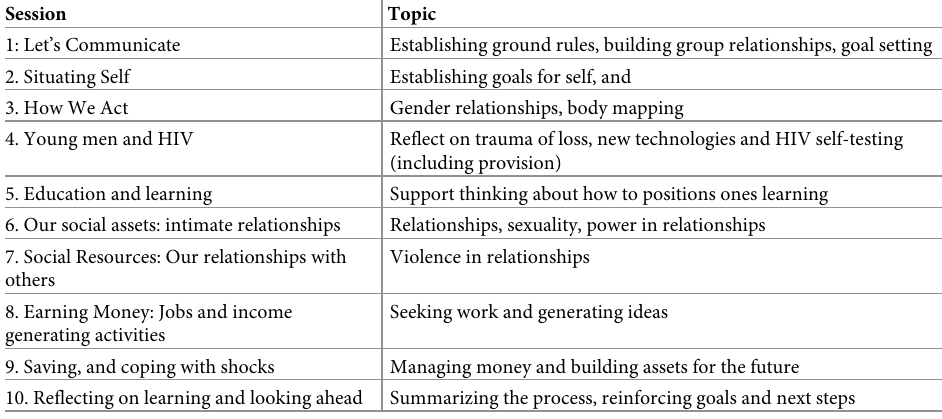
Table 4. Manualised Stepping Stones and Creating Futures intervention following